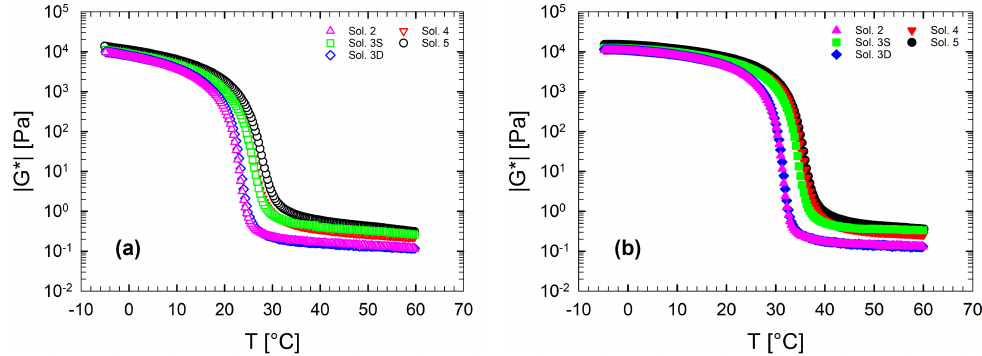
G ∗ | | , as a function of the temperature at 1 °C/min for multi-component